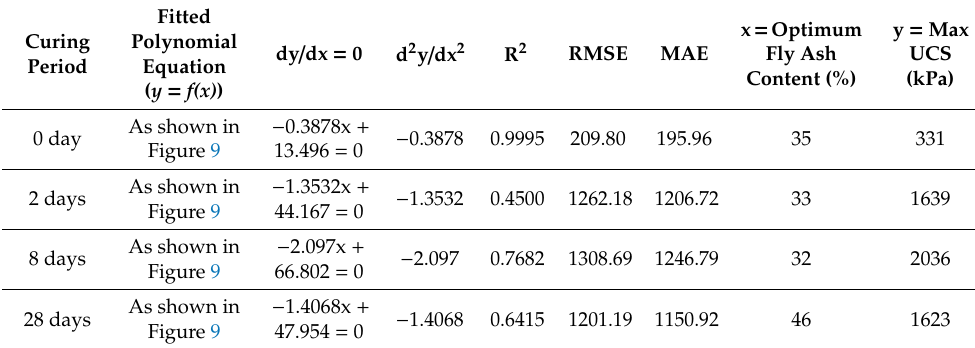
Table 4. Estimated optimum fly ash content and maximum UCS from the trend